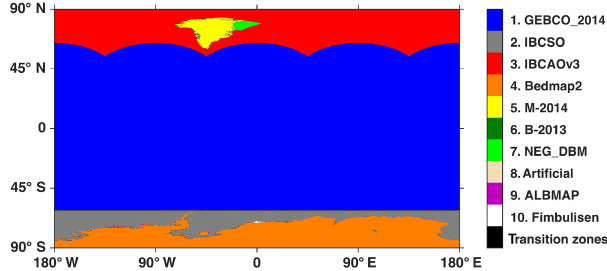
Figure 2. Data sources for the ocean bathymetry in RTopo-2. Black areas denote transition zones between the data sets (source flag 20). Further explanations are given in Table